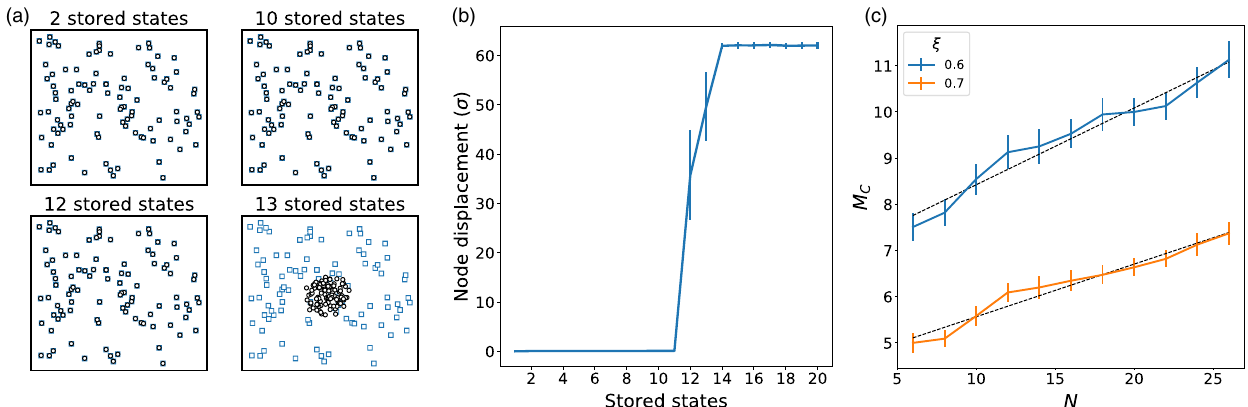
FIG. 10. Programming stored states using the learning paradigm exhibits finite capacity. (a) Each stored state is affected by springs associated with other states. Initially the new springs have a small effect and the state remains a stable attractor. However, eventually states destabilize due to the forces exerted by the other stored states (blue squares denote a certain stored state, black circles show the nearby stable configuration). This state fails when 13 states are simultaneously encoded ( N ¼ 100 , ξ ¼ 0 . 6 , σ ¼ 10 − 2 L ). (b) When node displacement is averaged over stored states, we observe a sharp failure of all states at a specific load, defined as the capacity (12 – 13 states in this case). (c) Capacity scales linearly with system size N